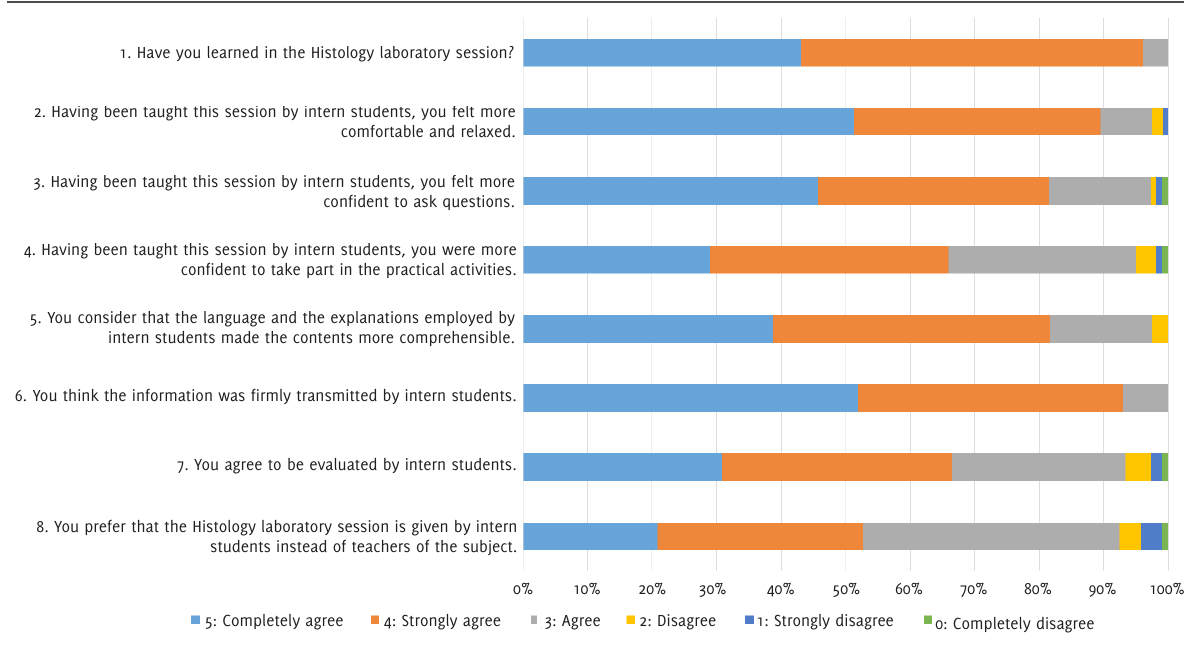
Figure 2. Students’ Reaction Evaluation to Histology Laboratory Session